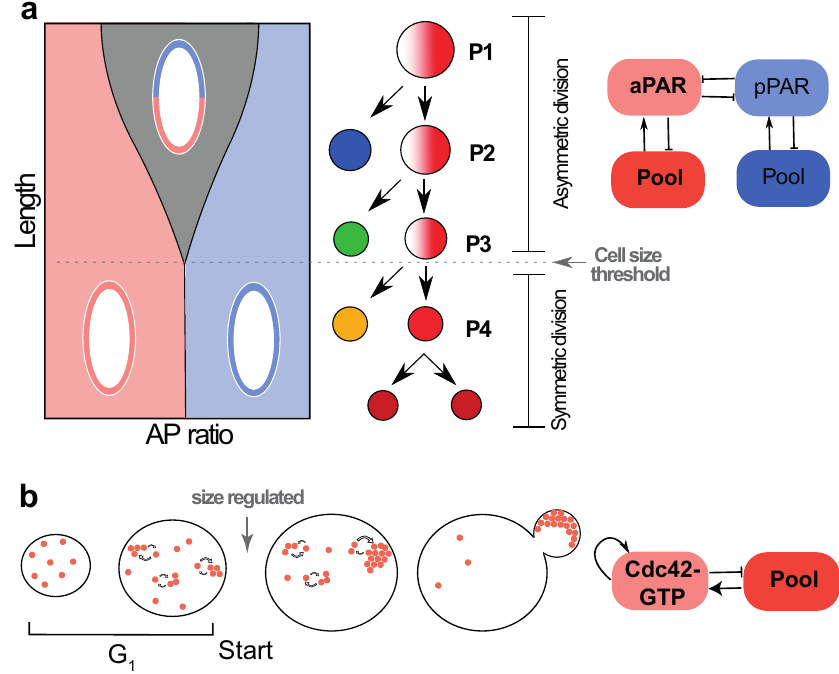
Figure 3. Size-regulated symmetry breaking in single cells. ( a ) A phase-diagram for the PAR system, considering polarisation state as a function of the circumferential length of the embryo (“Length”), and the ratio of aPAR to pPAR pool size (“AP ratio”). The diagram demonstrates a bipolar state (grey region) becomes unstable below a critical circumferential embryo length (pink and blue regions). Schematics for each of the three states are overlayed, with aPARs denoted in pink and pPARs denoted in blue. This bifurcation point quantitatively matches the critical size for which dividing P-cells in the early C. elegans embryo transition from asymmetric to symmetric division. Figure adapted from the work in [56]. Adjacent is the feedback motif that drives pattern formation. ( b ) In the budding yeast ( S. cerevisiae ), cell cycle commitment to Start is linked to the localisation of Cdc42 effectors at the presumptive bud site [58]. Cdc42 polarity establishment is related to the duration of the G 1 phase of the cell cycle, which ends at a critical cell size [59]. Models have shown that a growth process with positive feedback leads to Cdc42 polarisation at a single site